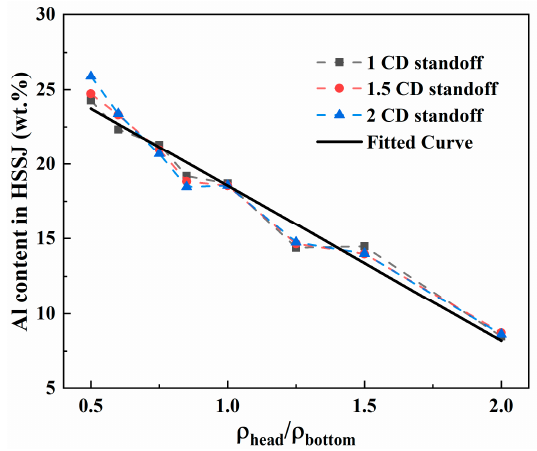
Figure 20. Fitted curve of the Al content in HSSJ of different initial particle distribution in liner.